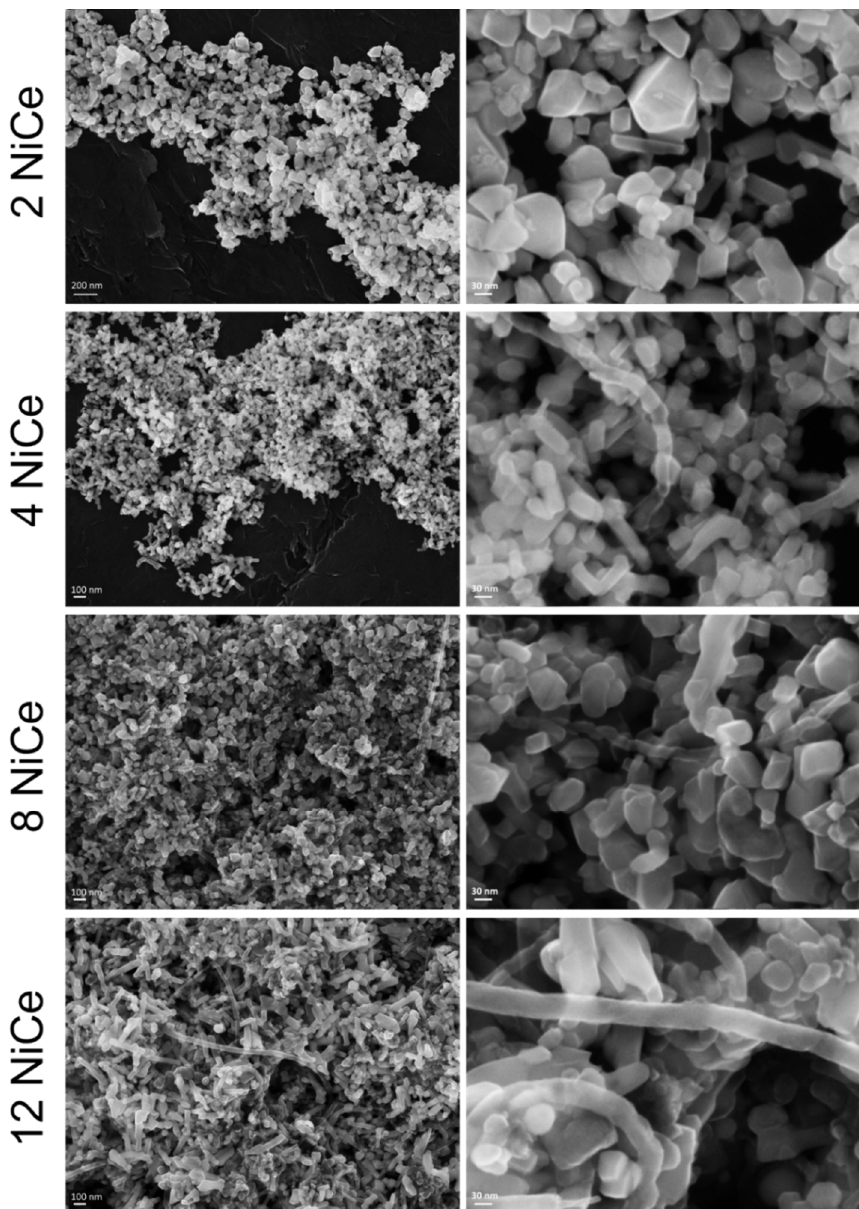
Figure 10. FE-SEM images of NiCe samples after TOS test for 15 h: enlargement 100 Kx ( left ) and 500 Kx ( right ).